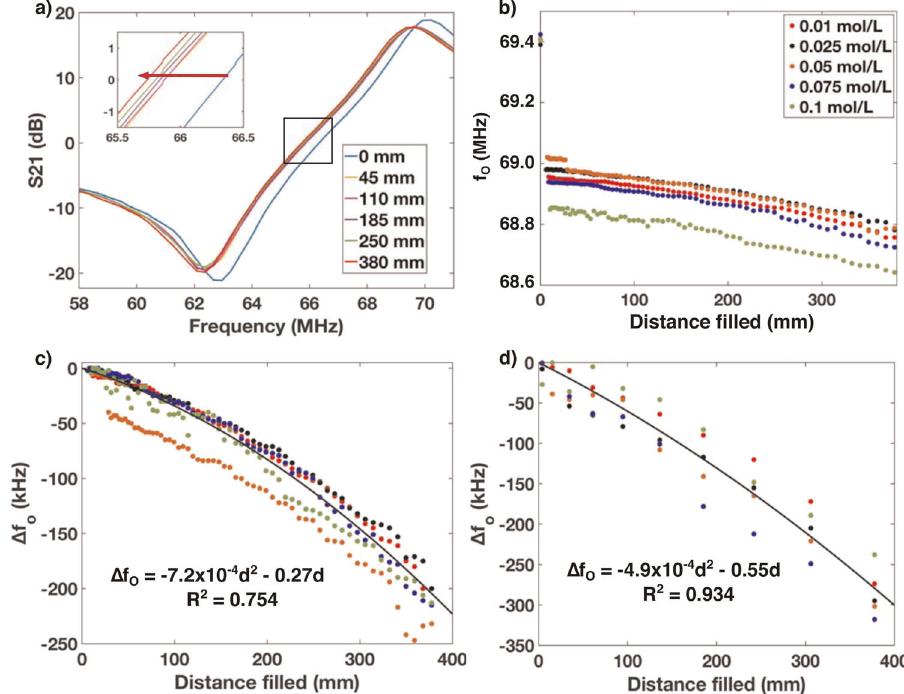
Fig. 4 Effect of fl uid fi lling on Δ f o. a Bode plot TL for frequency sweep of sticker with increasing (red arrow) distance fi lled in micro fl uidic channel. b Raw f o data from empty channel to completely fi lled for different concentrations of NaCl. c Normalized data from fi lling channel directly on the reader antenna for different sweat conductivities with model fi t (black line). d Normalized data from channel fi lled through PPE with model fi t (black